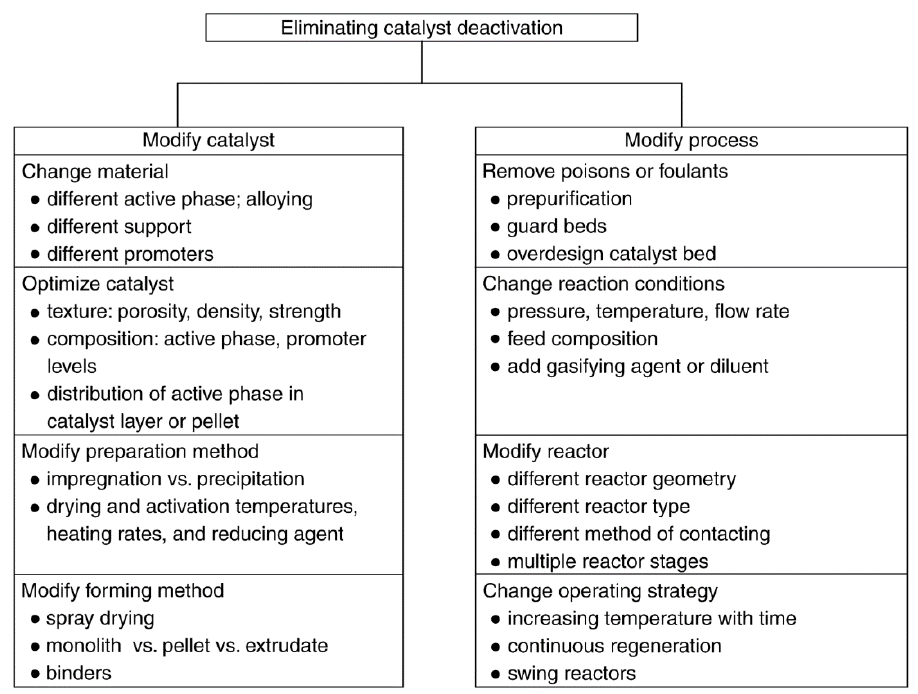
Figure 31. Approaches to eliminating catalyst